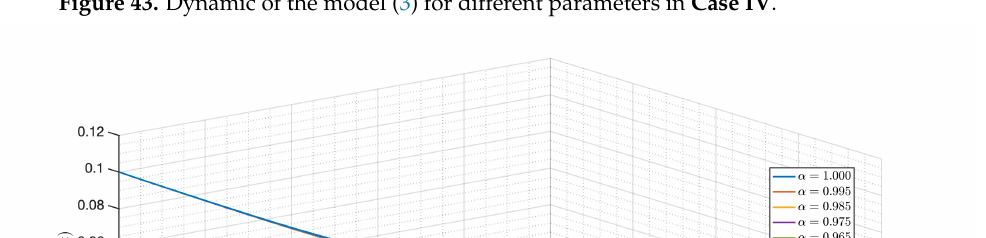
Figure 43. Dynamic of the model (3) for different parameters in Case IV .